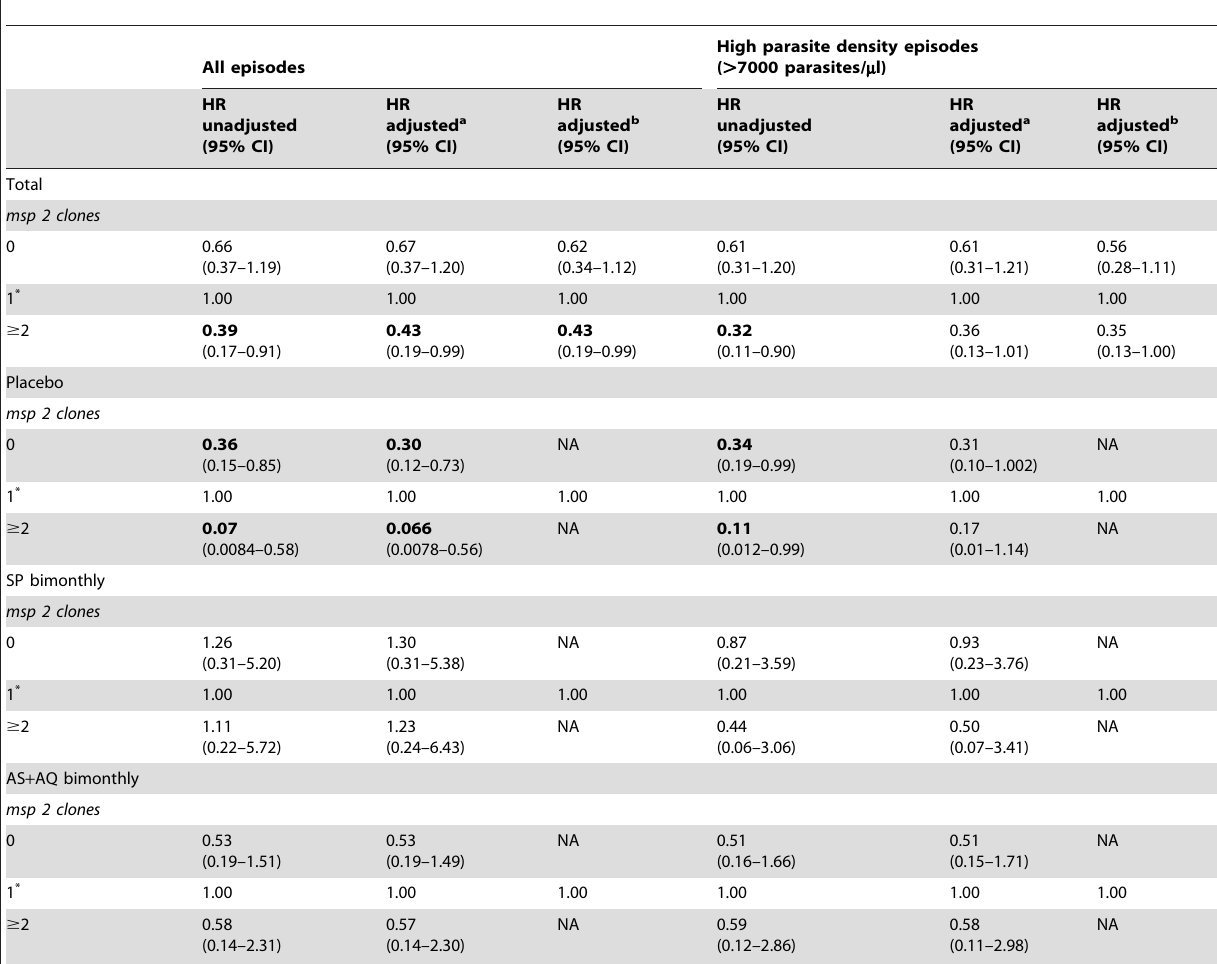
Table 2. Risk for subsequent clinical malaria in asymptomatic children (n=1856) during the 12 months follow up after the